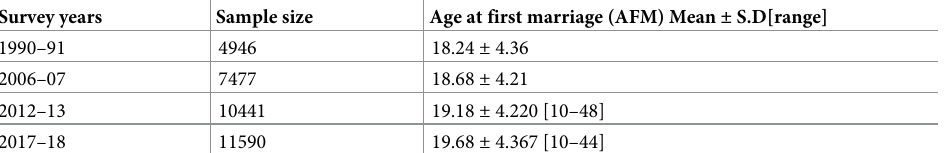
Table 3. Mean age at first marriage (AFM)) for currently married women aged 25–49 years: Four Pakistan Demo- graphic and Health Surveys (PDHSs) (1990–91, 2006–07, 2012–13 and 2017–18). Survey